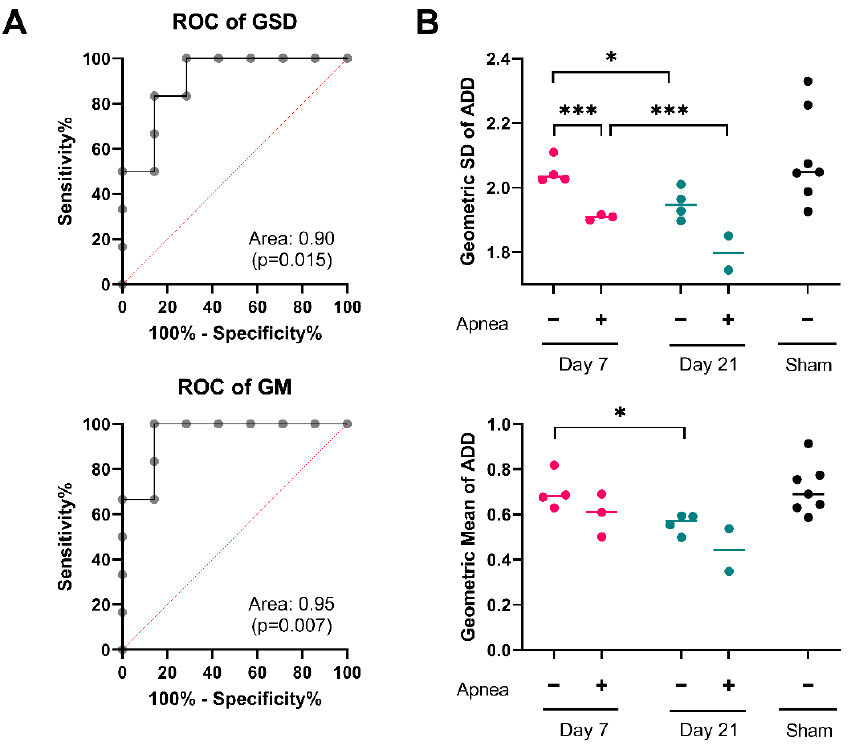
Figure 4. ADD signatures in individual mice. ( A ) Receiver operating characteristic curves for geometric standard deviation (GSD) and geometric mean (GM) of ADDs at 21 days post injury. ( B ) Changes in the GSD and GM of ADDs in individual mice after injury. Two-way ANOVA for the effects and interactions between post-injury apnea and survival after injury on the GSD of the ADD revealed significant contribution of both post-injury apnea, F 1,9 = 32.86; p < 0.001; and post-injury interval, F 1,9 = 13.45, p = 0.004. Mice that experience apnea showed evidence of a lower GSD of the ADD at day 7, t = 3.11, p < 0.001; but not at day 21 t = 3.11, p = 0.066. There was significant reduction in the GSD from day 7 to day 21 for both the apnea group, t = 2.76, p < 0.001, and the no apnea group, t = 3.19, p = 0.028. Similarly, the two-way ANOVA for the effects and interactions between post-injury apnea and survival after injury on the GM of the ADD revealed significant contribution of both post injury apnea, F 1,9 = 5.27; p = 0.044; and post-injury interval, F 1,9 = 9.10, p = 0.009. Mice that experience apnea did not show evidence of a different GM of the ADD at day 7, t = 1.54, p = 0.171 or at day 21 t = 1.75, p = 0.139. There was significant reduction in the GM from day 7 to day 21 for the no apnea group, t = 3.106, p = 0.029, but not in the apnea group, t = 1.59, p = 0.206. *, p < 0.05; ***, p < 0.001.